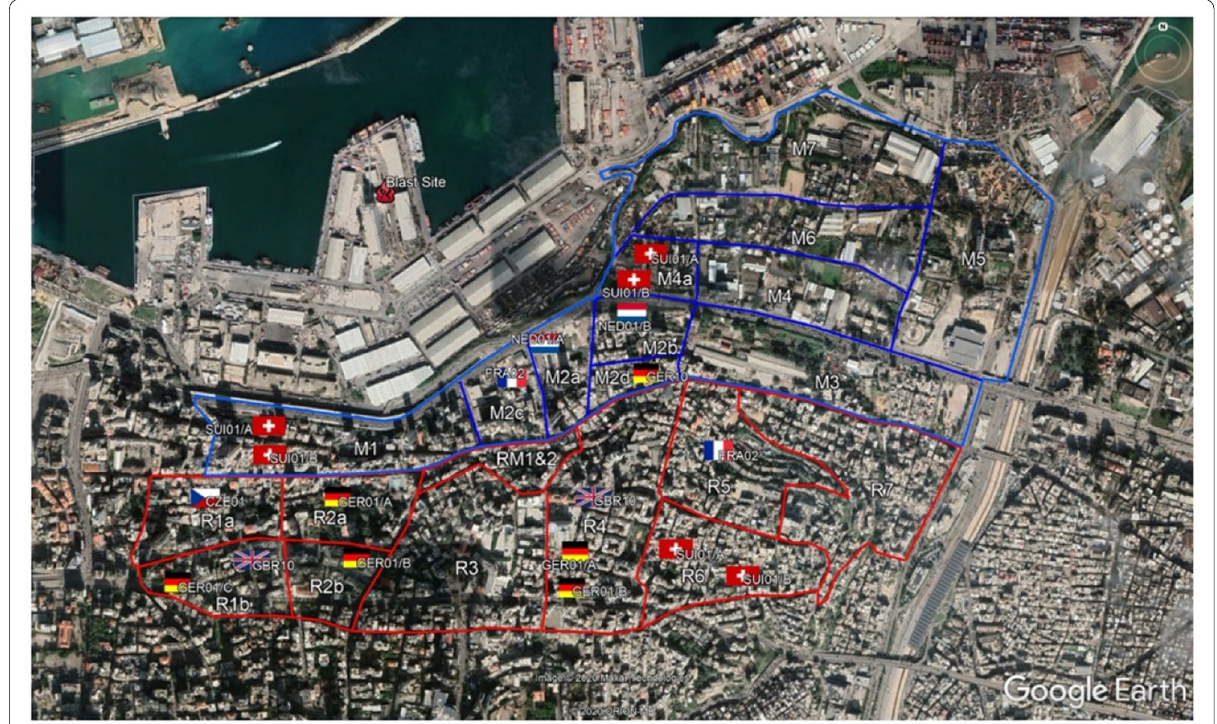
Fig. 1 Sectors and the location of assessment teams in Beirut (provided by